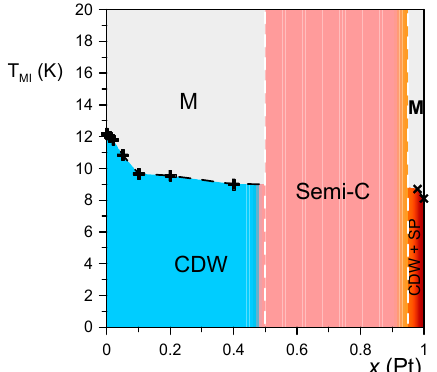
Figure 7. Phase diagram of the (Per) 2 [Pt x ‐ Au (1 − x ) (mnt) 2 ] system. At left, for α‐ phase, it occurred a Peierls transition from a metal (M) towards a Charge Density Wave (CDW) ground state with a Curie–Weiss behaviour of the anions. At the extreme right in the α‐ phase, the CDW ground state of the donor stacks coexisted with a spin ‐ Peierls (SP) ground state in the anionic chains. The spin ‐ Peierls ground state was not suppressed by small concentrations (up to ~2%) of diamagnetic impurities. In the range x = 0.50 to 0.95, only semiconducting β‐ phase crystals could be obtained.